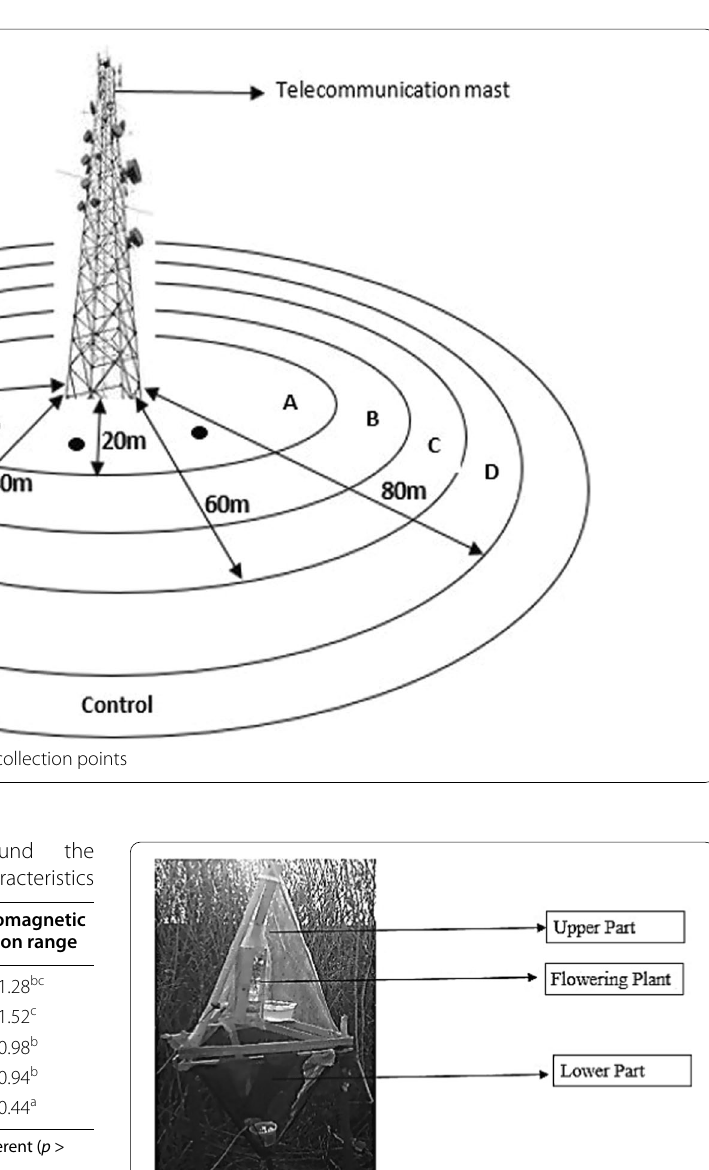
Values along column with different superscript are significantly different ( p > 0.05)